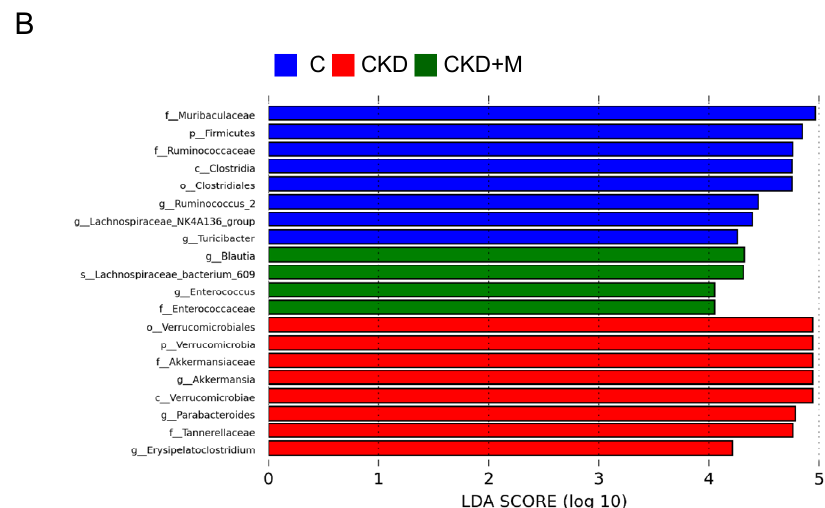
Figure 5. Linear discriminant analysis effect size (LEfSe) was applied to microbial marker discovery in metagenomic data. Here, are the most enriched and depleted bacterial taxa in ( A ) males and ( B ) females. C (blue) versus CKD (red) and CKD + M (green) are shown. Different taxonomic levels of bacteria are given, reaching from phylum down to the genus level. The threshold of the linear discriminant was set to four.